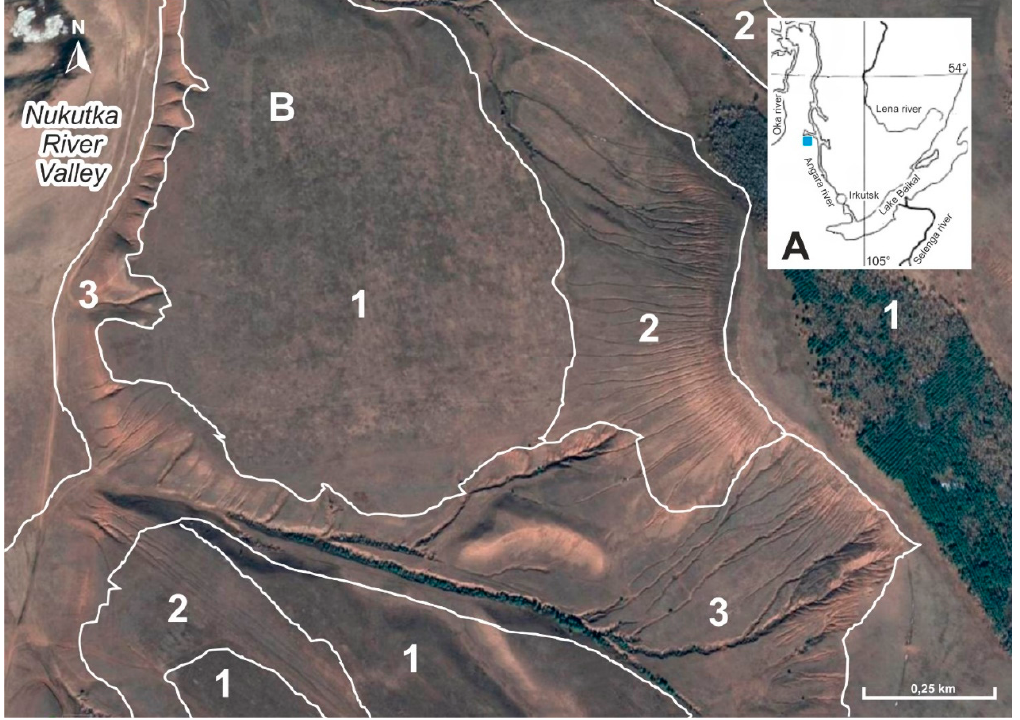
Figure 5. Erosion belts scheme for the area, adjusting to the Unga Bay of the Bratsk Reservoir. A . Location of the area (marked with a blue square), B . Erosion belts: 1. splash erosion, 2. Rill erosion, 3. Gully erosion. Based on the satellite image Google Earth. Coordinates: 53° 43’ 37.16 ‘’N; 102°49’ 33.56’’ E. The image was taken on October 4, 2019